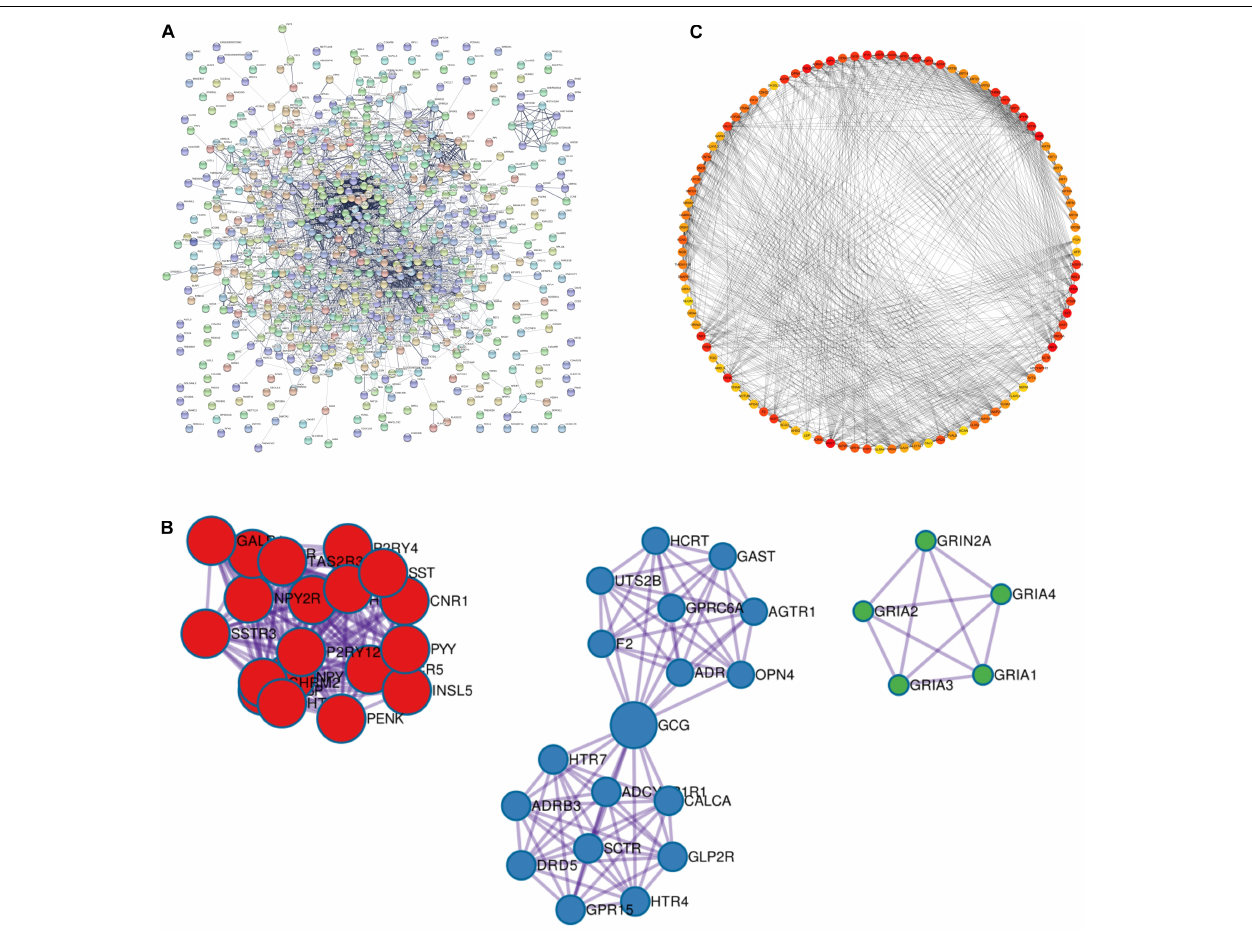
FIGURE 2 | PPI network build results. (A) PPI network diagram, every dot in the network represents a node, the more lines connected to the dot, the larger the degree representing this node. It means that the gene on this node may be more important in the network structure. (B) The three main clustering modules in the PPI network. (C) MCC degree higher top 100 genes in the network screened by the algorithm, the darker the red color indicates the higher the degree.